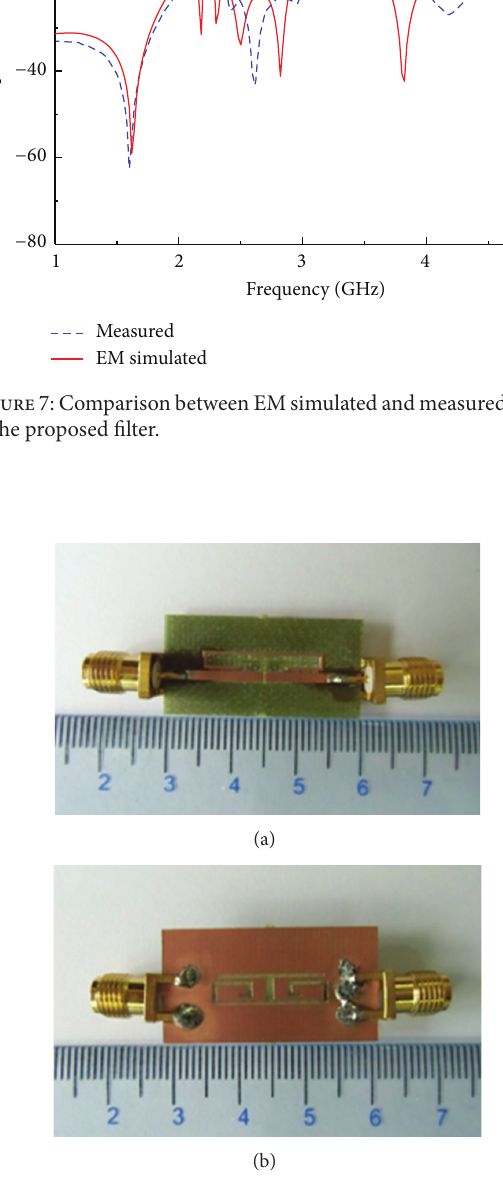
Figure 8: Photographs of the fabricated filter: (a) top view and (b) bottom